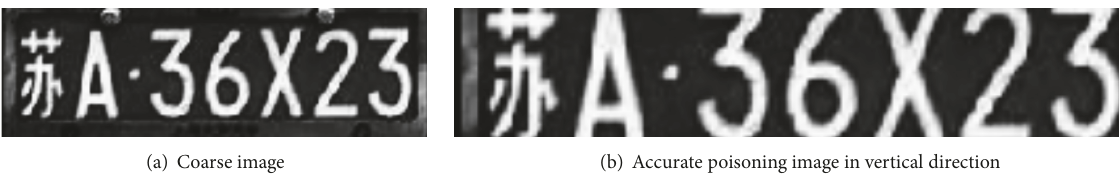
Figure 5: Difference in coarse image and processed image.